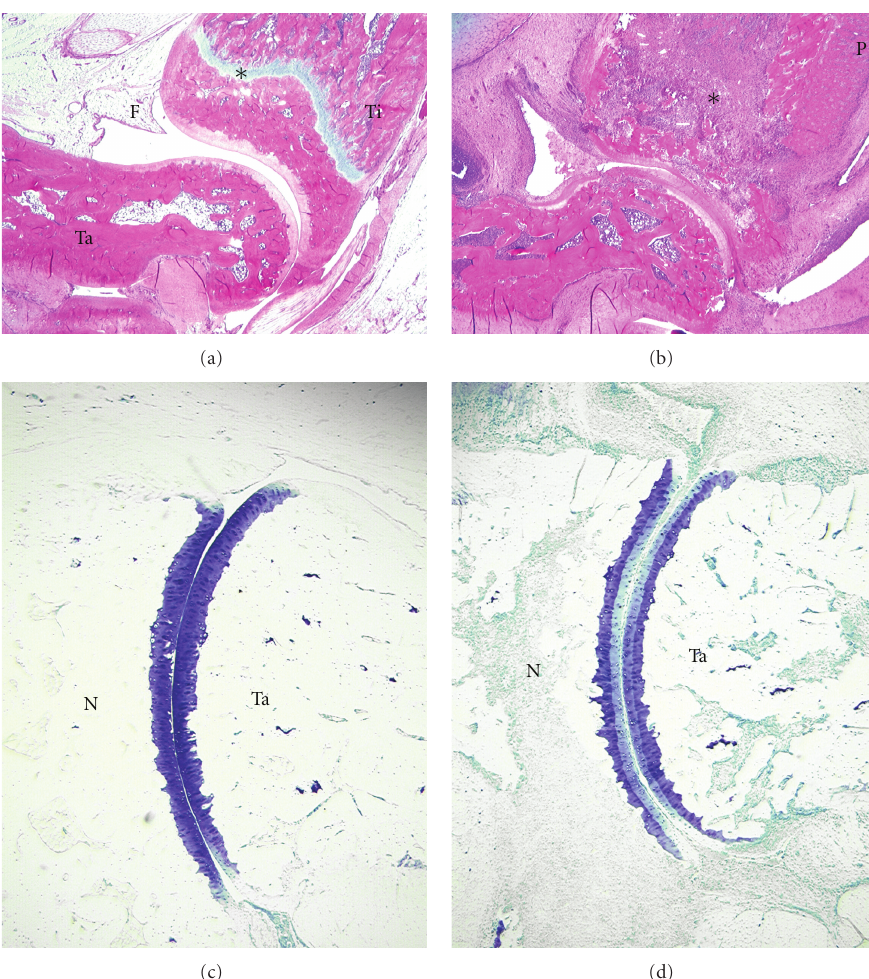
Figure 6: Structural lesions of immune-mediated joint disease in arthritic rodents include both skeletal and soft tissue changes. Relative to nonarthritic control animals ((a) and (c)), young adult, male Lewis rats with the aggressive mycobacterial variant of adjuvant-induced arthritis (AIA-Myc) ((b) and (c)) develop extensive inflammation of the fatty periarticular soft tissues (F) and bone marrow, erosion of cortical and trabecular bone, loss of physeal (growth plate) cartilage (asterisks ( ∗ )), and exuberant production of periosteal bone (P). Fibrin, inflammatory cells, and (for CIA) pannus are additional features that may be evident on hematoxylin and eosin (H&E)-stained sections ((a) and (b)). Cartilage degeneration is demonstrated by toluidine blue staining ((c) and (d)), with the normal uniform dark purple labeling of surface and deep articular cartilage in nonarthritic controls (c) being replaced in inflamed joints by loss of staining in the superficial matrix of arthritic rats (d). Extensive loss of subchondral and trabecular bone (pale white plates and columns adjacent to cartilage) results from extensive infiltration of the bone marrow by inflammatory cells (punctate gray/green fields between bones in (d)). Abbreviations: N = navicular tarsal bone, Ta = talus, Ti =